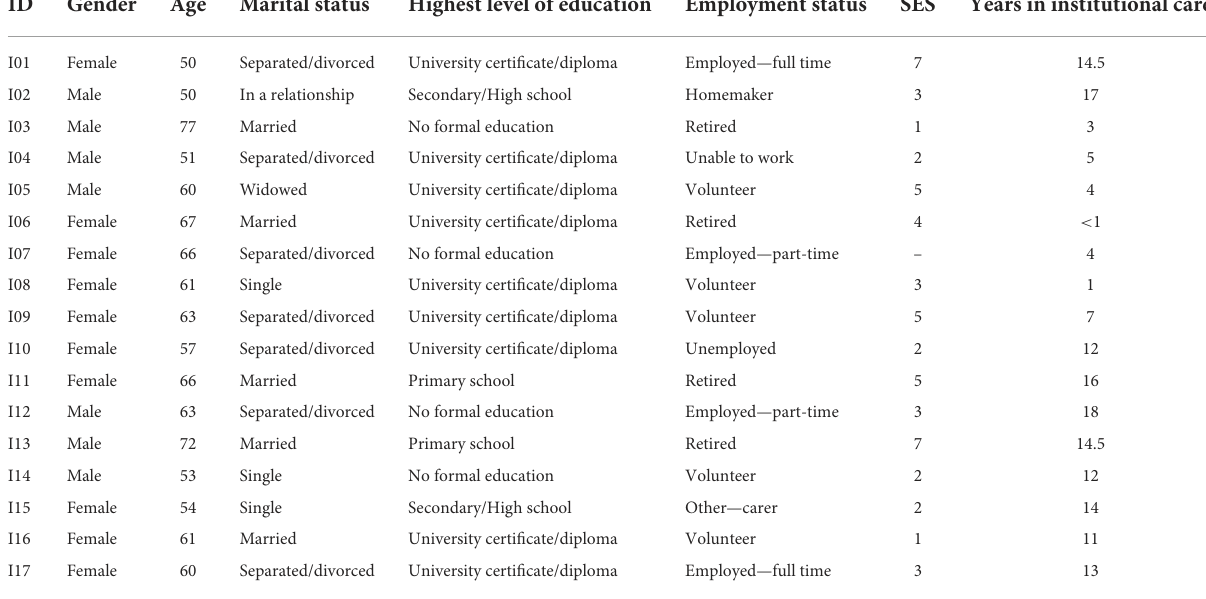
SES,Subjectiveevaluationofsocio-economicstatus:rangingfrom1(lowest)to10(highest).ParticipantIDusesFtorepresentthe(familial)intrafamilialsample. TABLE 2 Participant characteristics for the institutional